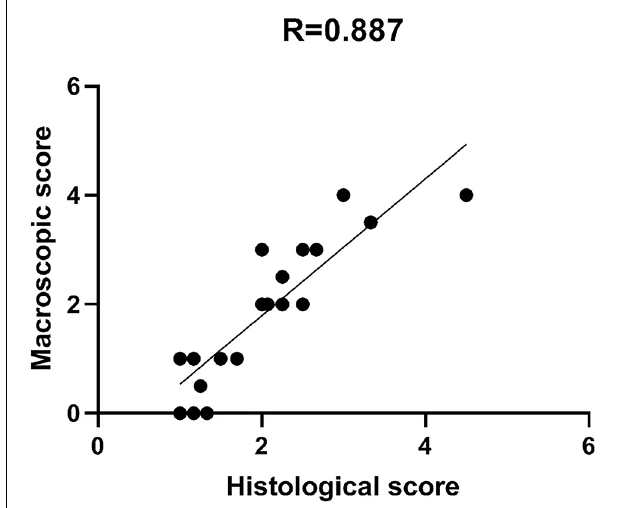
FIGURE 5 | Macro and microscopic cartilage score correlation. Scatter plot representation of the correlation between macroscopic and histological scores for the evaluation of cartilage degeneration. Histological score is the mean of triplicate evaluations from the same area, performed by two independent